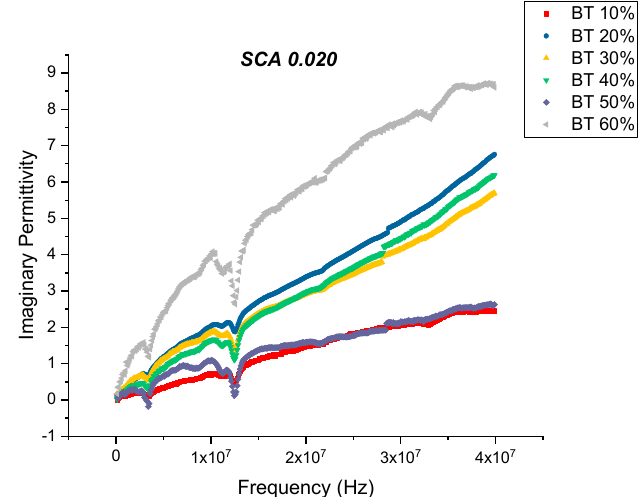
Figure 13. The dielectric loss of the BaTiO 3 -epoxy composite that were fabricated using BaTiO 3 nanoparticles which were surface modified using 0.020 SCA is plotted as a function of frequency where the volume fraction of BaTiO 3 is varied from 0.1 to 0.6. The maximum value is 5.89 for BaTiO 3 at 0.6 volume fraction.